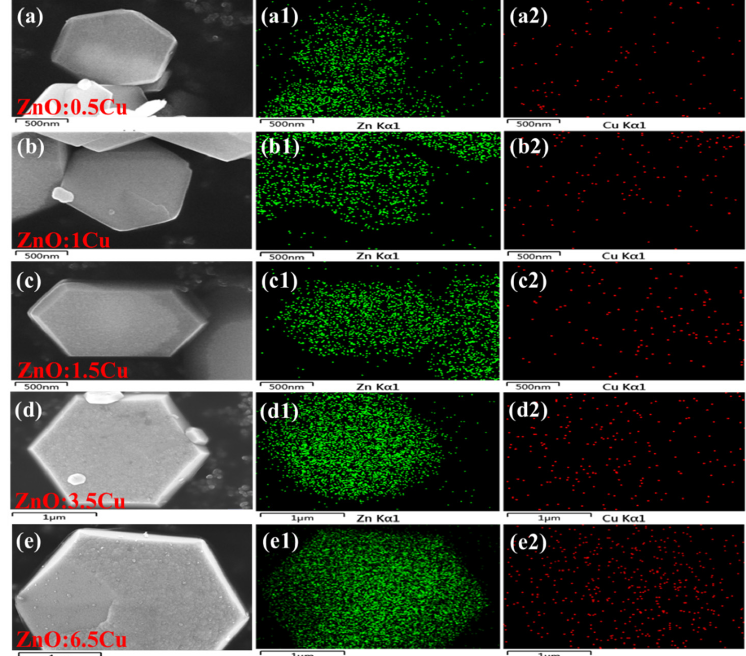
Figure 1. SEM images and corresponding elemental mapping of the reduced catalysts: ZnO:0.5Cu ( a – a2 ), ZnO:1Cu ( b – b2 ), ZnO:1.5Cu ( c – c2 ), ZnO:3.5Cu ( d – d2 ) and ZnO:6.5Cu ( e – e2